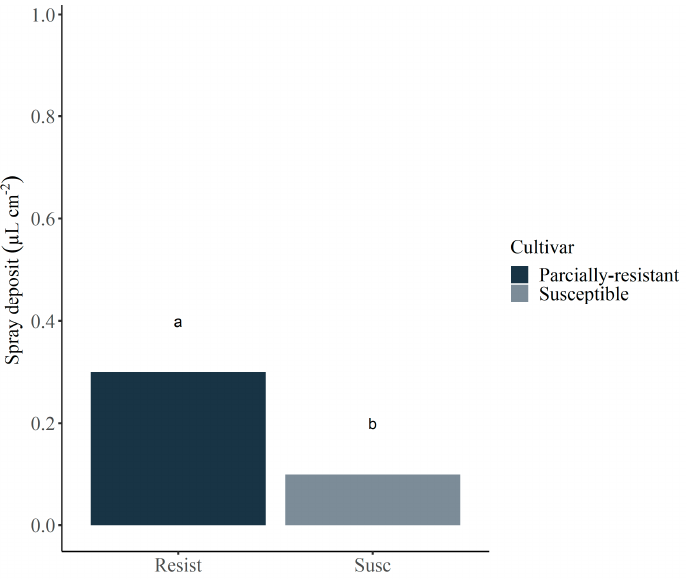
Figure 5. Mean deposit values ( μ L cm − 2 ) that were collected in the lower region of the soybean canopy of different soybean cultivars in the first application of Field 1. The means followed by the same letter did not differ by the Tukey test at 5% probability ( p < 0.05).